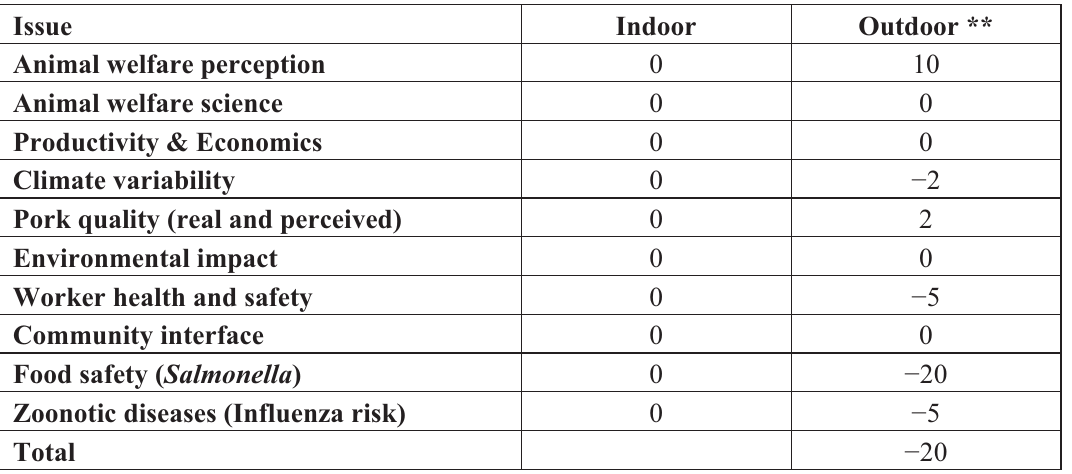
Table 2. Comparisons of Outdoor and Indoor production systems in a sustainability matrix, with the indoor, industrialized system as a baseline * . Issue Indoor Outdoor ** Animal welfare perception